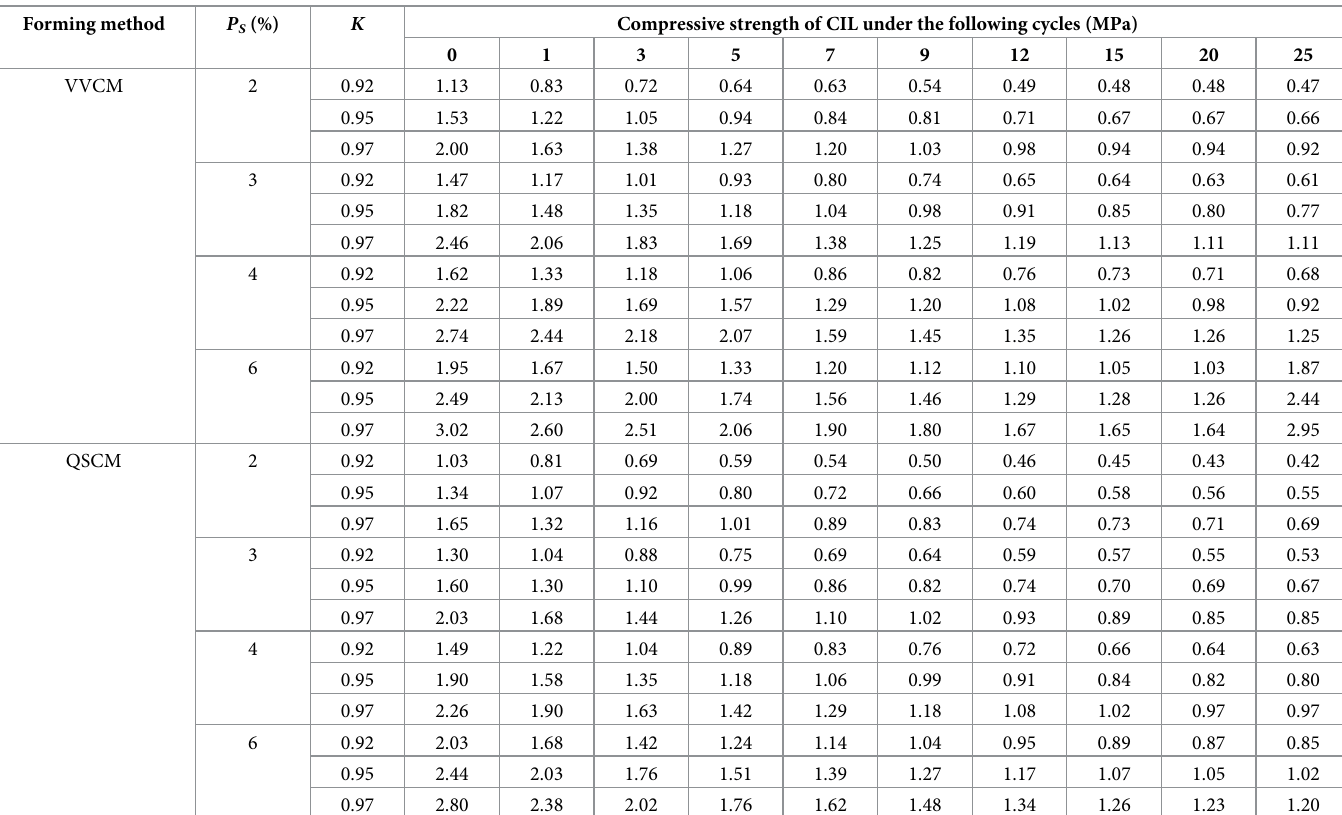
Table 3. 28d compressive strength of CIL under dry–wet cycles. Forming